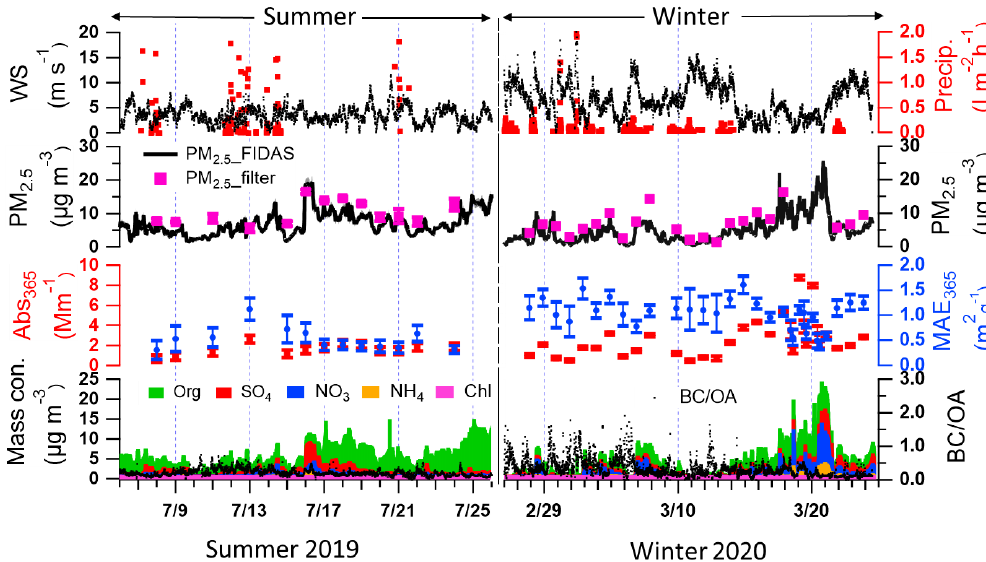
Figure 1. Time series of wind speed, precipitation, PM 2 . 5 mass concentrations from FIDAS optical particle sizer and gravimetric analysis of filter samples, optical properties of methanol-soluble aerosol particle compounds (Aqualog), concentrations of non-refractory aerosol particle compounds (AMS), and ratios of BC / OA in summer 2019 and the following winter.